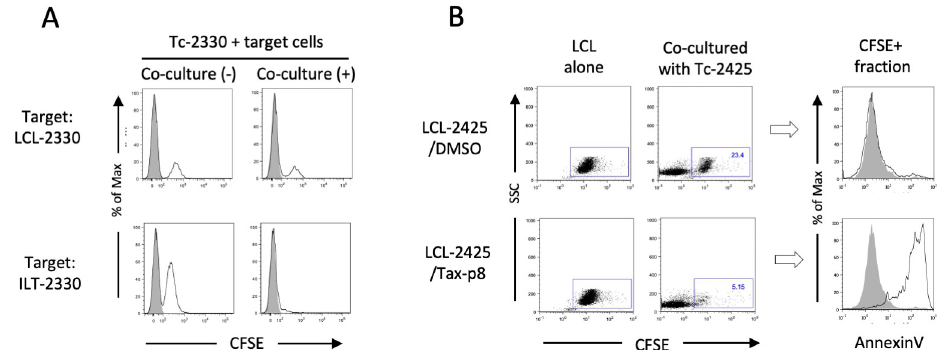
Fig 8. Cytotoxic functions of STLV-1-specific CTLs induced by the autologous PBMC vaccines. A. CTLs induced from monkey #2330 (Tc-2330) after vaccination were co-cultured with CFSE-labelled LCL-2330 (top) or ILT-2330 (bottom) cells overnight (co-culture [+]), and then subjected to flow cytometry. As a control, target cells and CTLs that had been separately cultured overnight were mixed on ice just before flow cytometry (co-culture [-]). Closed histograms represent CTLs alone as a negative control. B. LCL-2425 cells that had been pulsed with DMSO (top) or 10 μ M Tax-p8 peptides (bottom) were CFSE-labelled and co-cultured for 6 h with CTLs induced from monkey #2425 (Tc-2425) after vaccination. The cells were then stained with annexin V followed by flow cytometry. Dot plots represent LCLs cultured alone or co-cultured with Tc-2425, and histograms represent annexin V-binding cells in the CFSE + fraction in the co-culture. Closed histograms indicate CFSE + LCLs alone, while open histograms indicate the CFSE + LCLs co-cultured with CTLs.